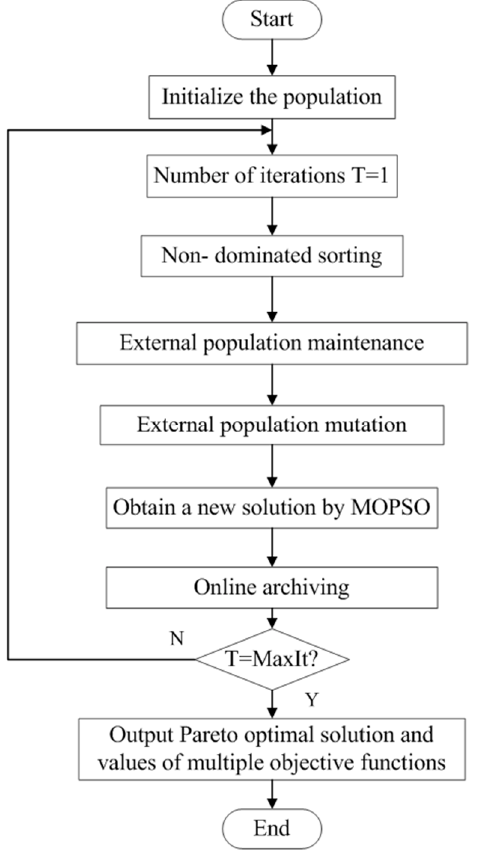
Figure 3. Trajectory optimization algorithm flow.